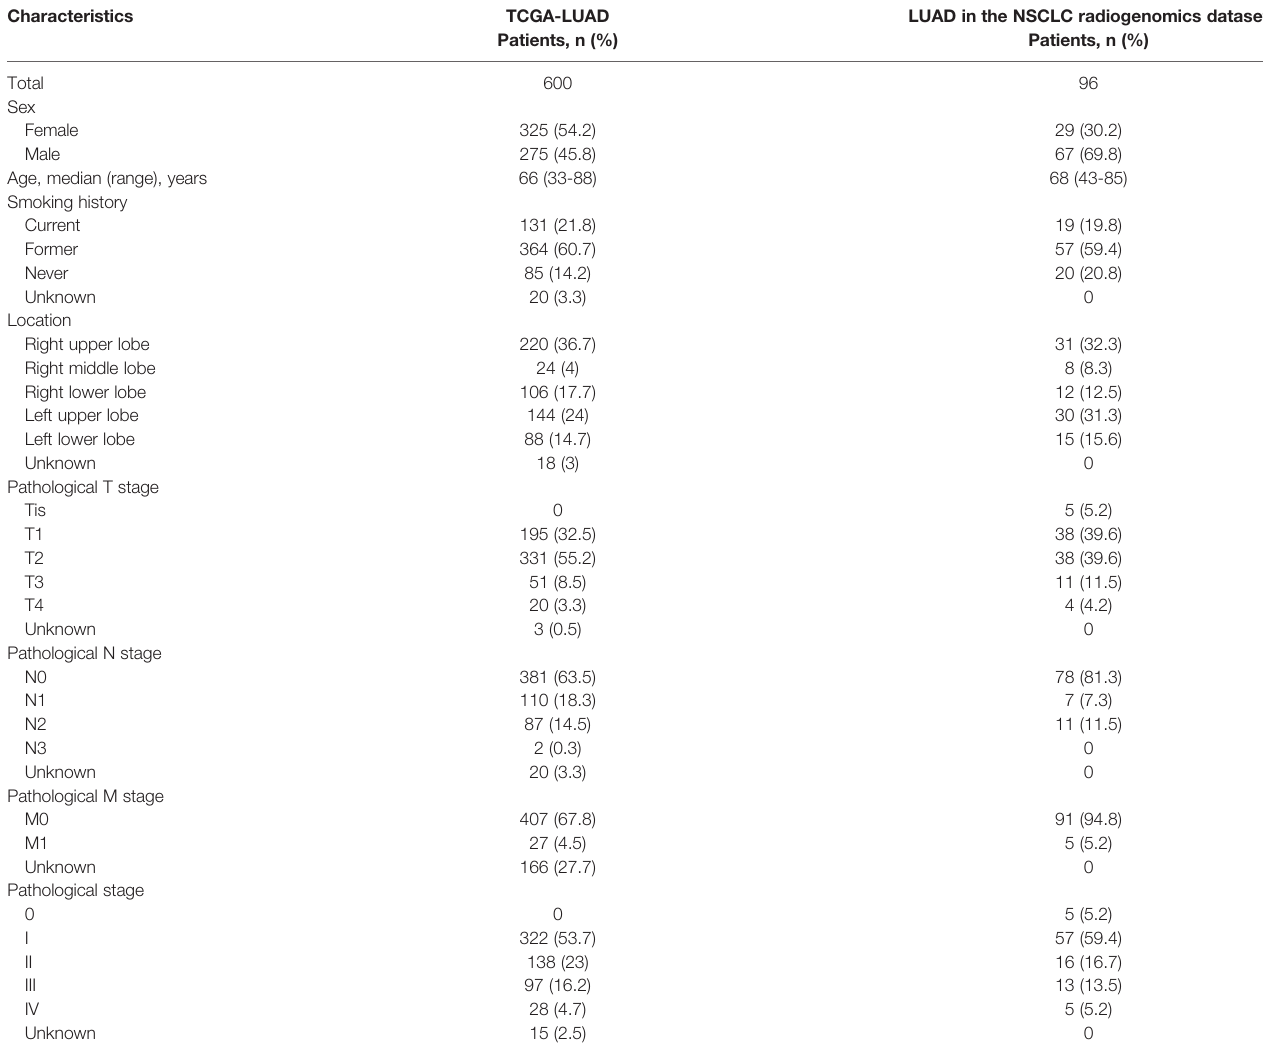
TABLE 1 | Demographic and clinical characteristics of the patients.